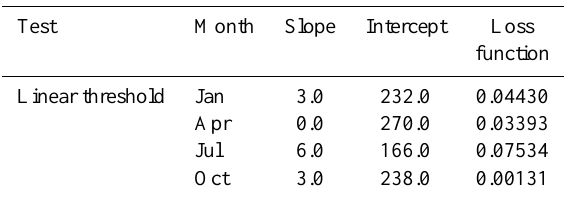
Table 4. The definition values of the linear threshold test during four